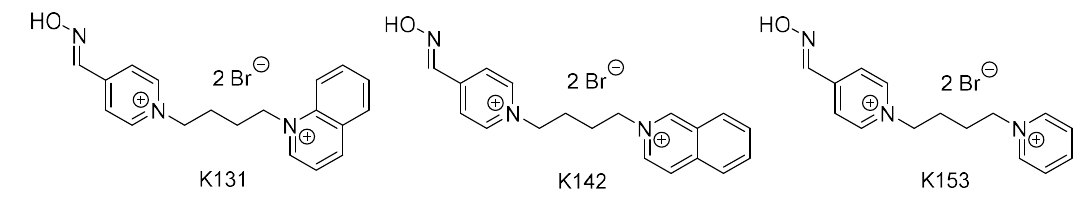
Figure 2. Chemical structures of the cholinesterase reactivators synthesized.